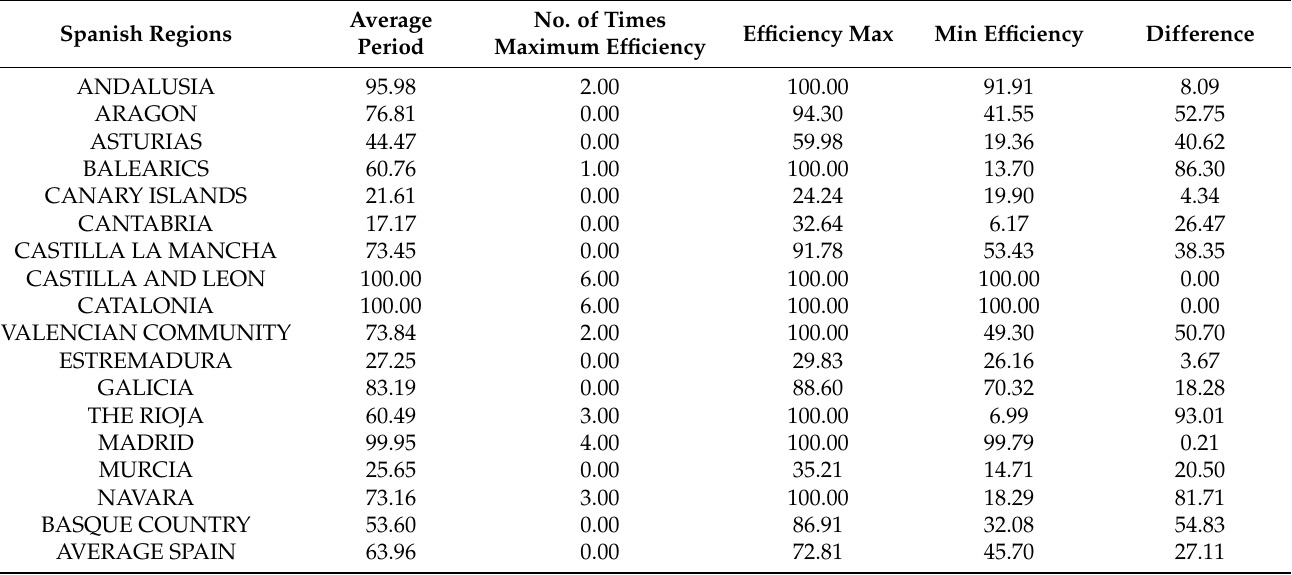
Table 6. Basic statistical